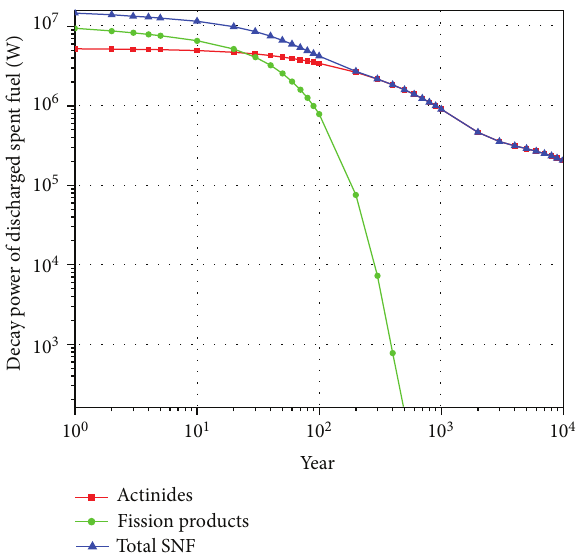
F 9: Decay heat generated by accumulated spent fuel mass out of pile in 2022 with �ssion product and actinides